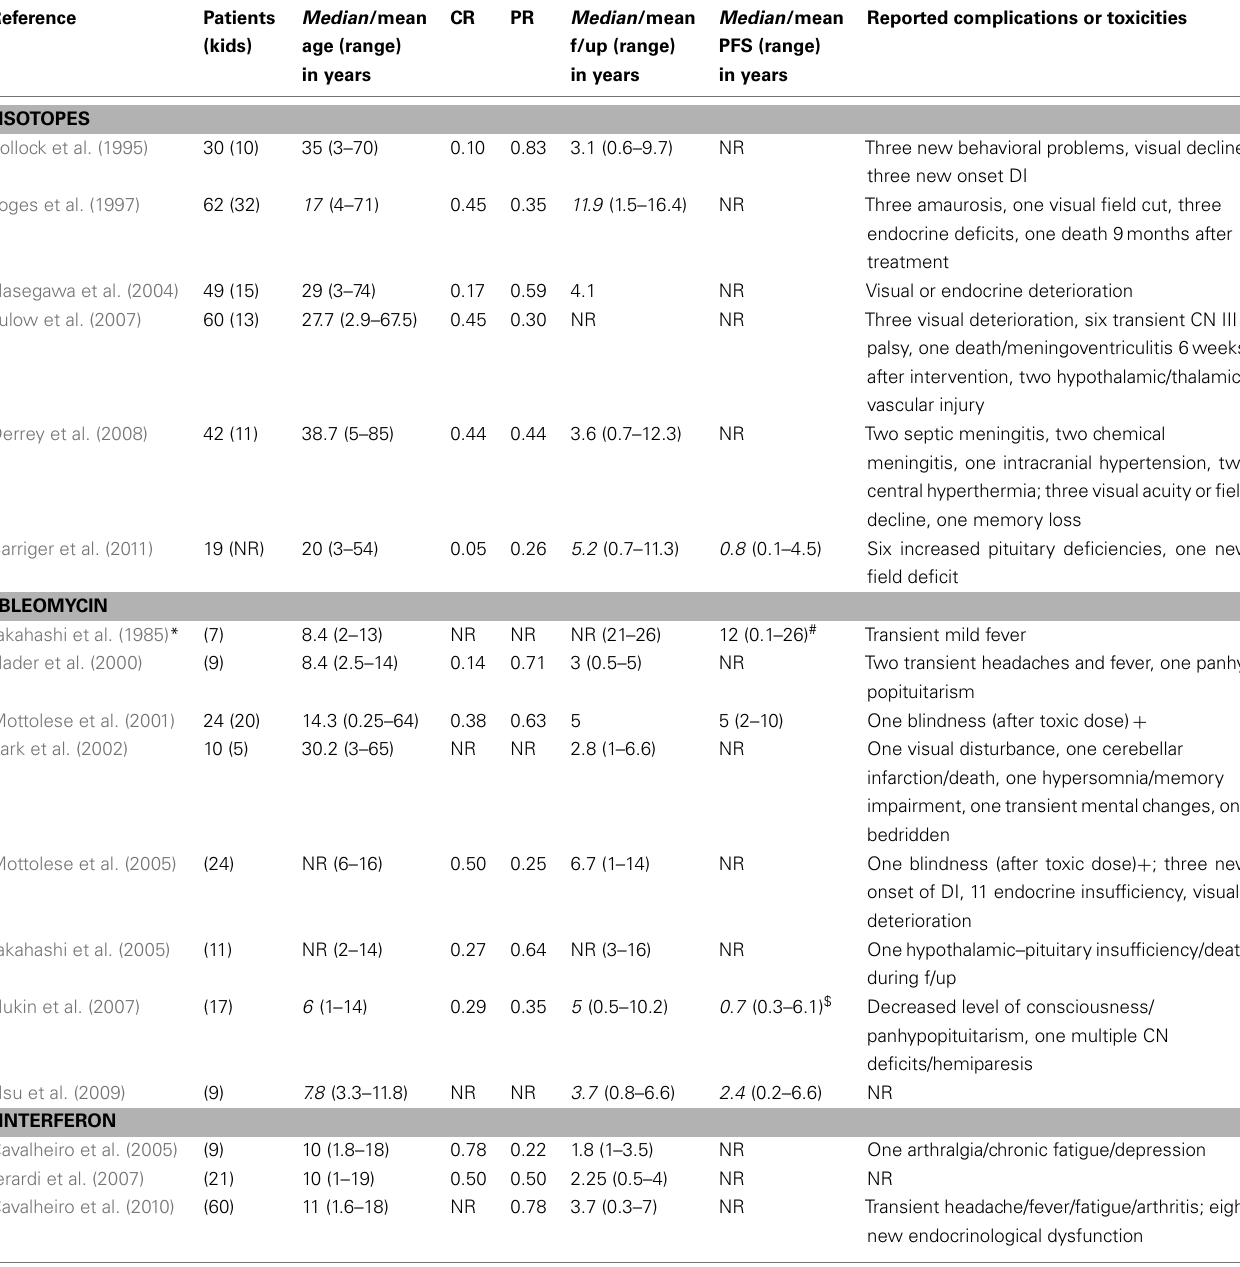
Table 1 | Intracystic treatment modalities in craniopharyngiomas – retrospective reviews including